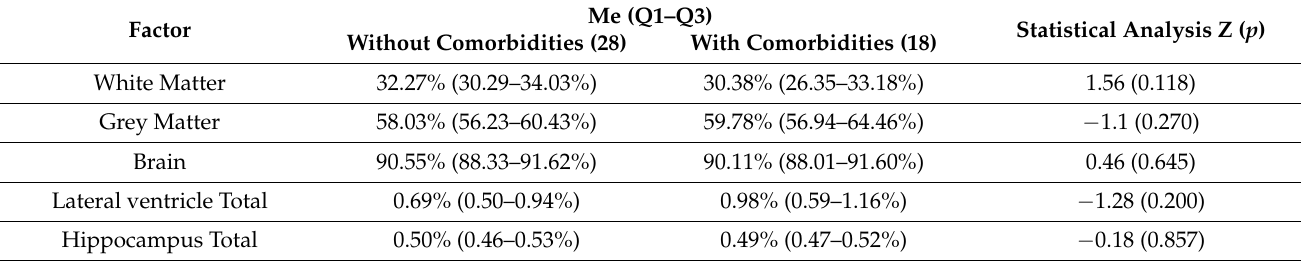
Table 4. Comparing the values of particular variables in children with epilepsy. Descriptive statistics (N, median with lower and upper quartiles) with the statistical analysis (Mann–Whitney U test). Me (Q1–Q3) Factor Statistical Analysis Z ( p ) Without Comorbidities (28) With Comorbidities